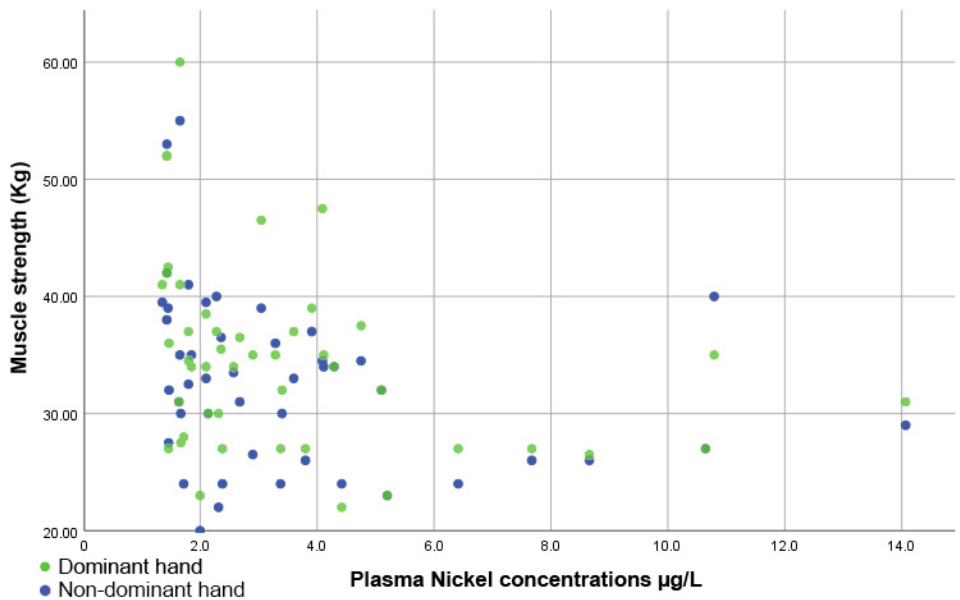
Figure 5. Scatter plot showing the inversely proportional correlation between muscle strength and plasma nickel levels.